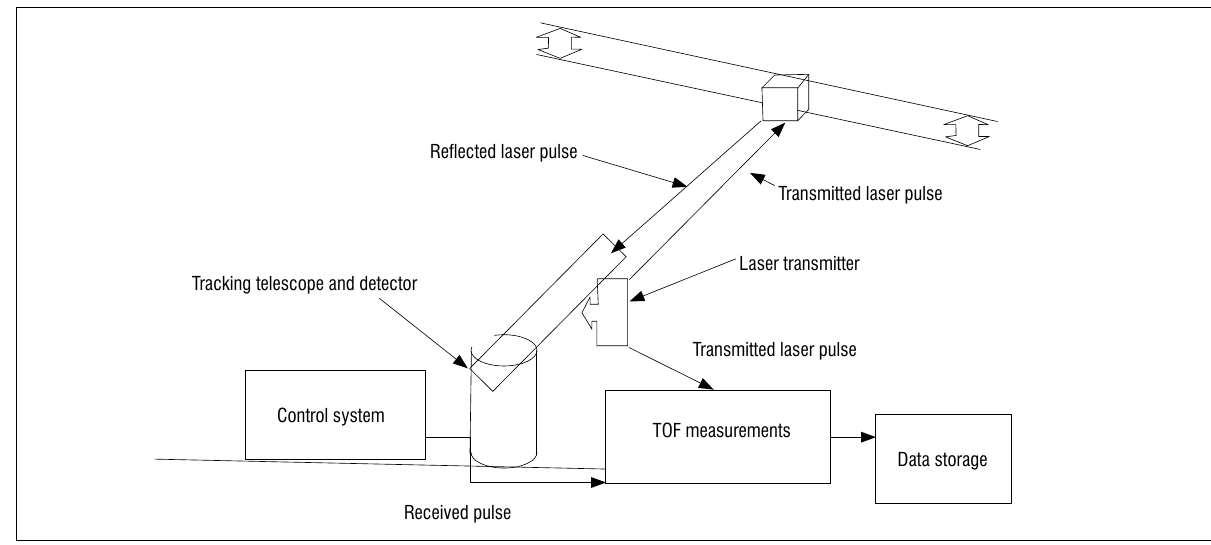
Figure 1: Illustration of the satellite laser ranging concept. The timing component is critical and needs to be accurate to a picosecond